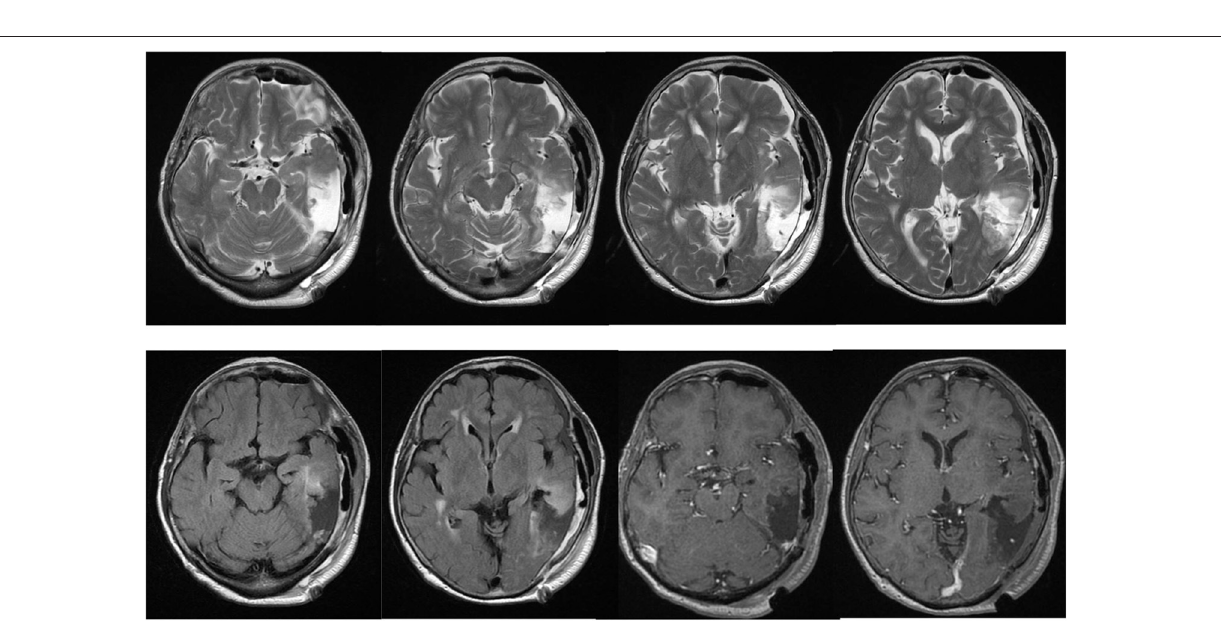
FIGURE 4 | Postoperative MRI showing gross total removal of the